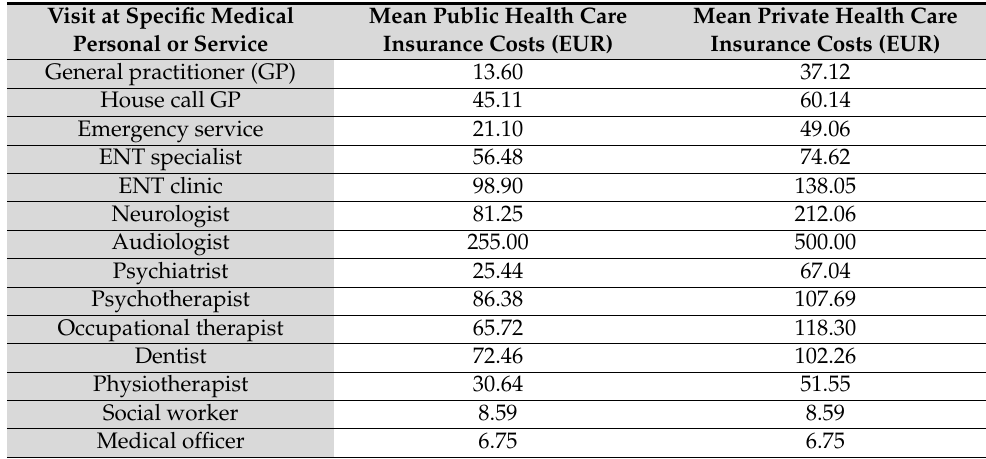
Table 2. Costs of for the health care system for one